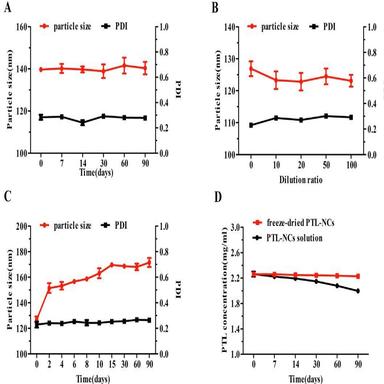
The particle size and PDI of the PTL-NCs after (A) lyophilization, (B) dilution, (C) storage at 4 °C. (D) The PTL concentration of the PTL-NCs solution and freeze-dried PTL-NCs during a 90-day's storage. Data are presented as mean ± SD (n = 3).